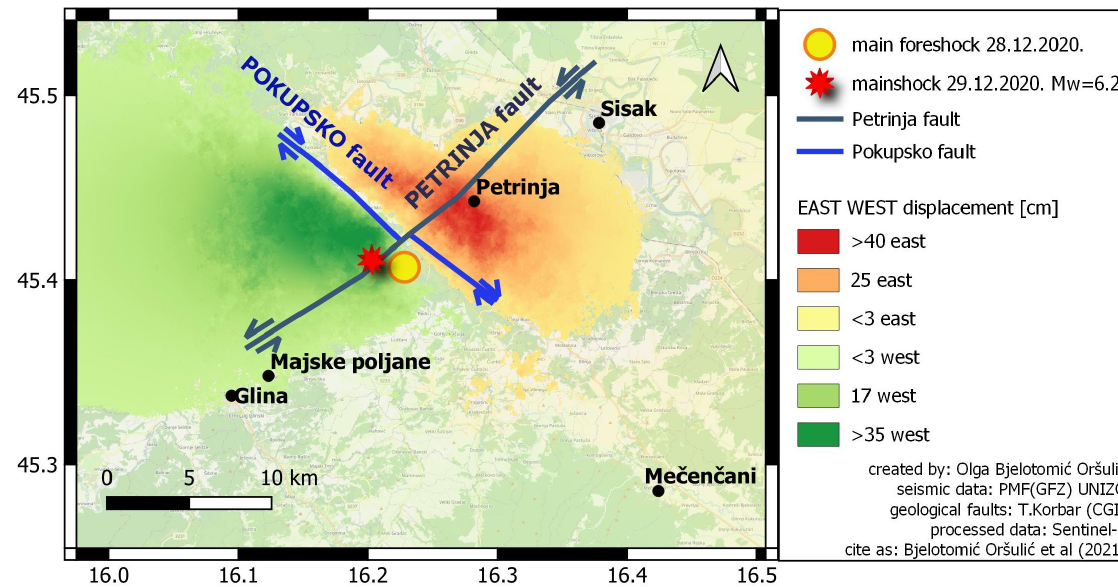
Figure 8. Figure shows east–west ground displacement over affected